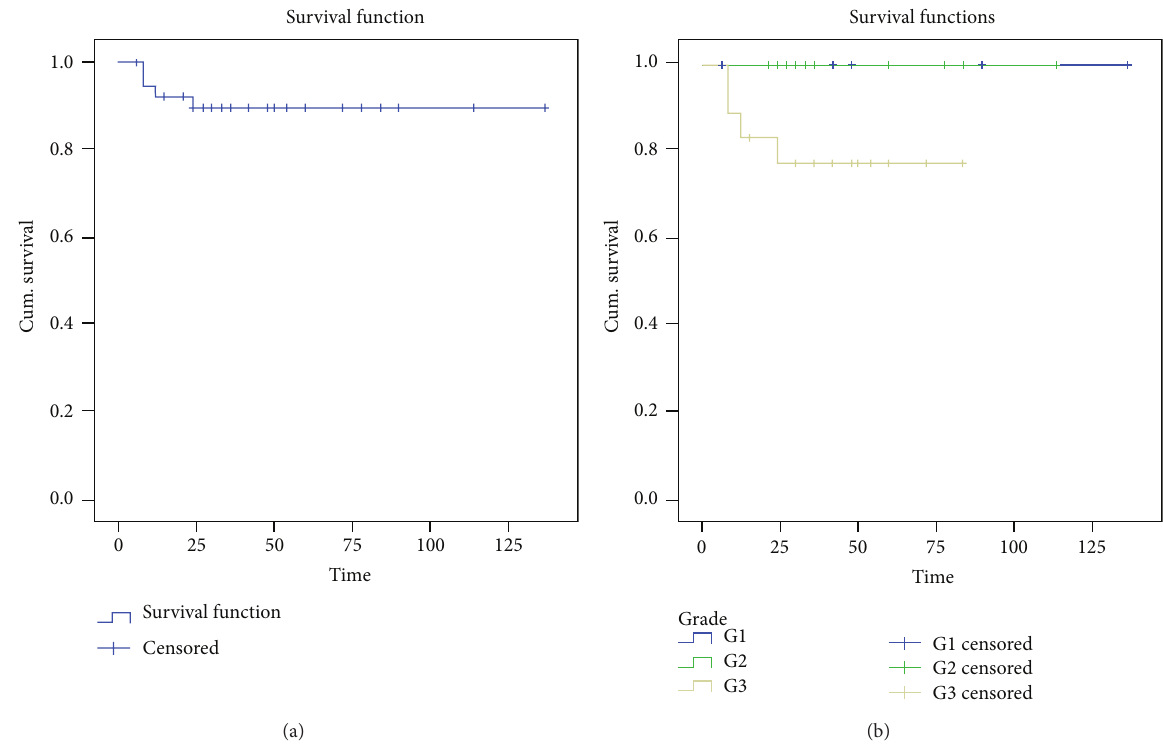
Figure 1: Kaplan-Meier survival curve for pancreatic endocrine neoplasms ( 𝑛 = 40 ) overall and by grade. (a) The Kaplan-Meier survival curve is shown with the number of patients at risk. (b) The neoplasms were grouped by the grade of the